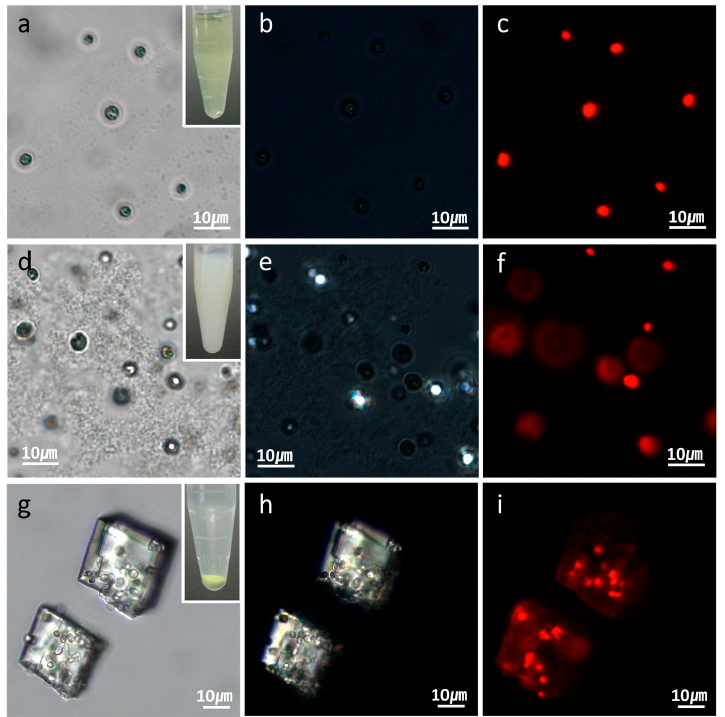
Figure 2. Optical-microscopic images of ( a – c ) microalgal suspension; ( d – f ) microalgal suspension immediately after the CaCl 2 and Na 2 CO 3 solutions were mixed; and ( g – i ) the same suspension with ( d – f ) after two hours. The optical-microscopic images are in the ( a , d , g ) bright-field; ( b , e , h ) cross-polarization; and ( c , f , i ) fluorescence modes. The red fluorescence in ( c , f , i ) originated from the autofluorescence of the microalgae’s chlorophyll.